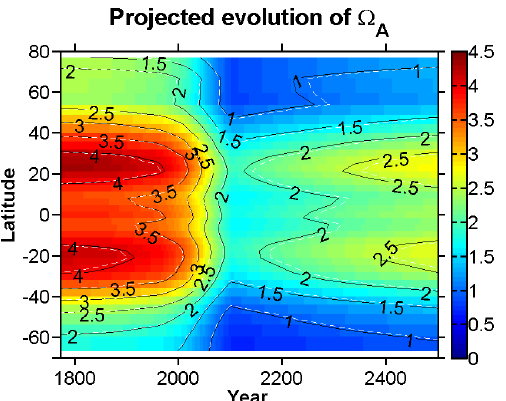
Fig. 12. Projected evolution of the aragonite saturation state in the surface ocean (top 125m) for the High emission commitment sce- nario where carbon emissions increase in the 21st century following scenario RCP8.5. Color scale and black contour lines represent val- ues from the CALARAG version that includes aragonite and calcite production. White contour lines are from the version with CaCO 3 production independent of the saturation state (NODEPCA).